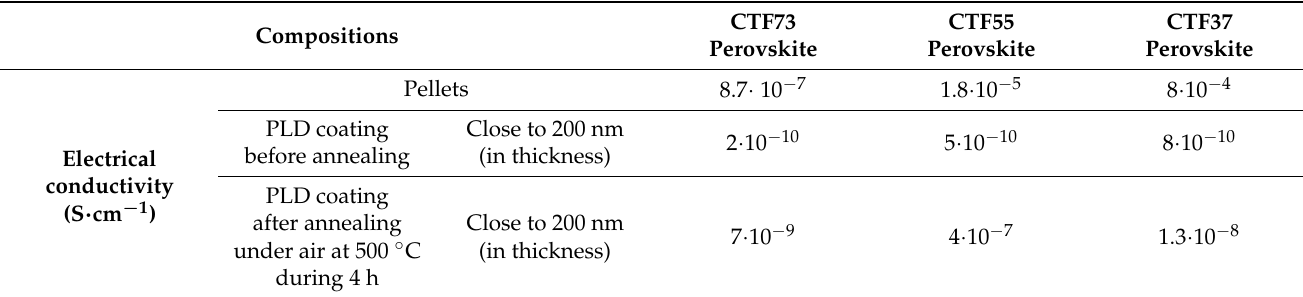
Table 2. Electrical Conductivity Measurement of CTF Perovskite Materials on the Pellets and on the PLD Thin